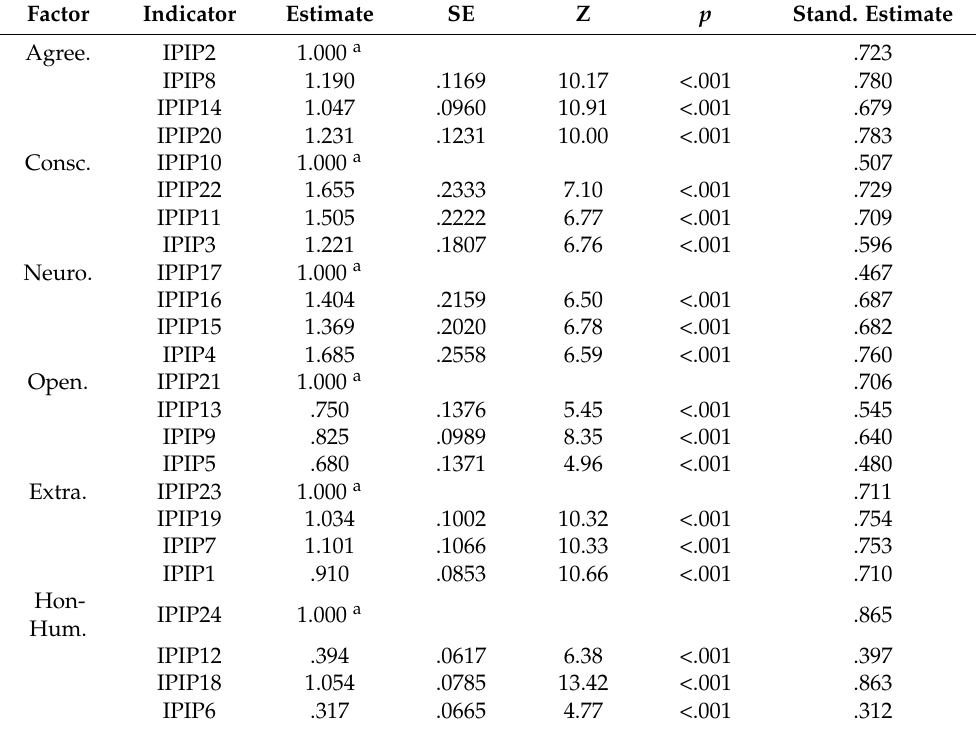
Table A1. Cont. Factor Indicator Estimate SE Z p Stand. Estimate Extra. IPIP23